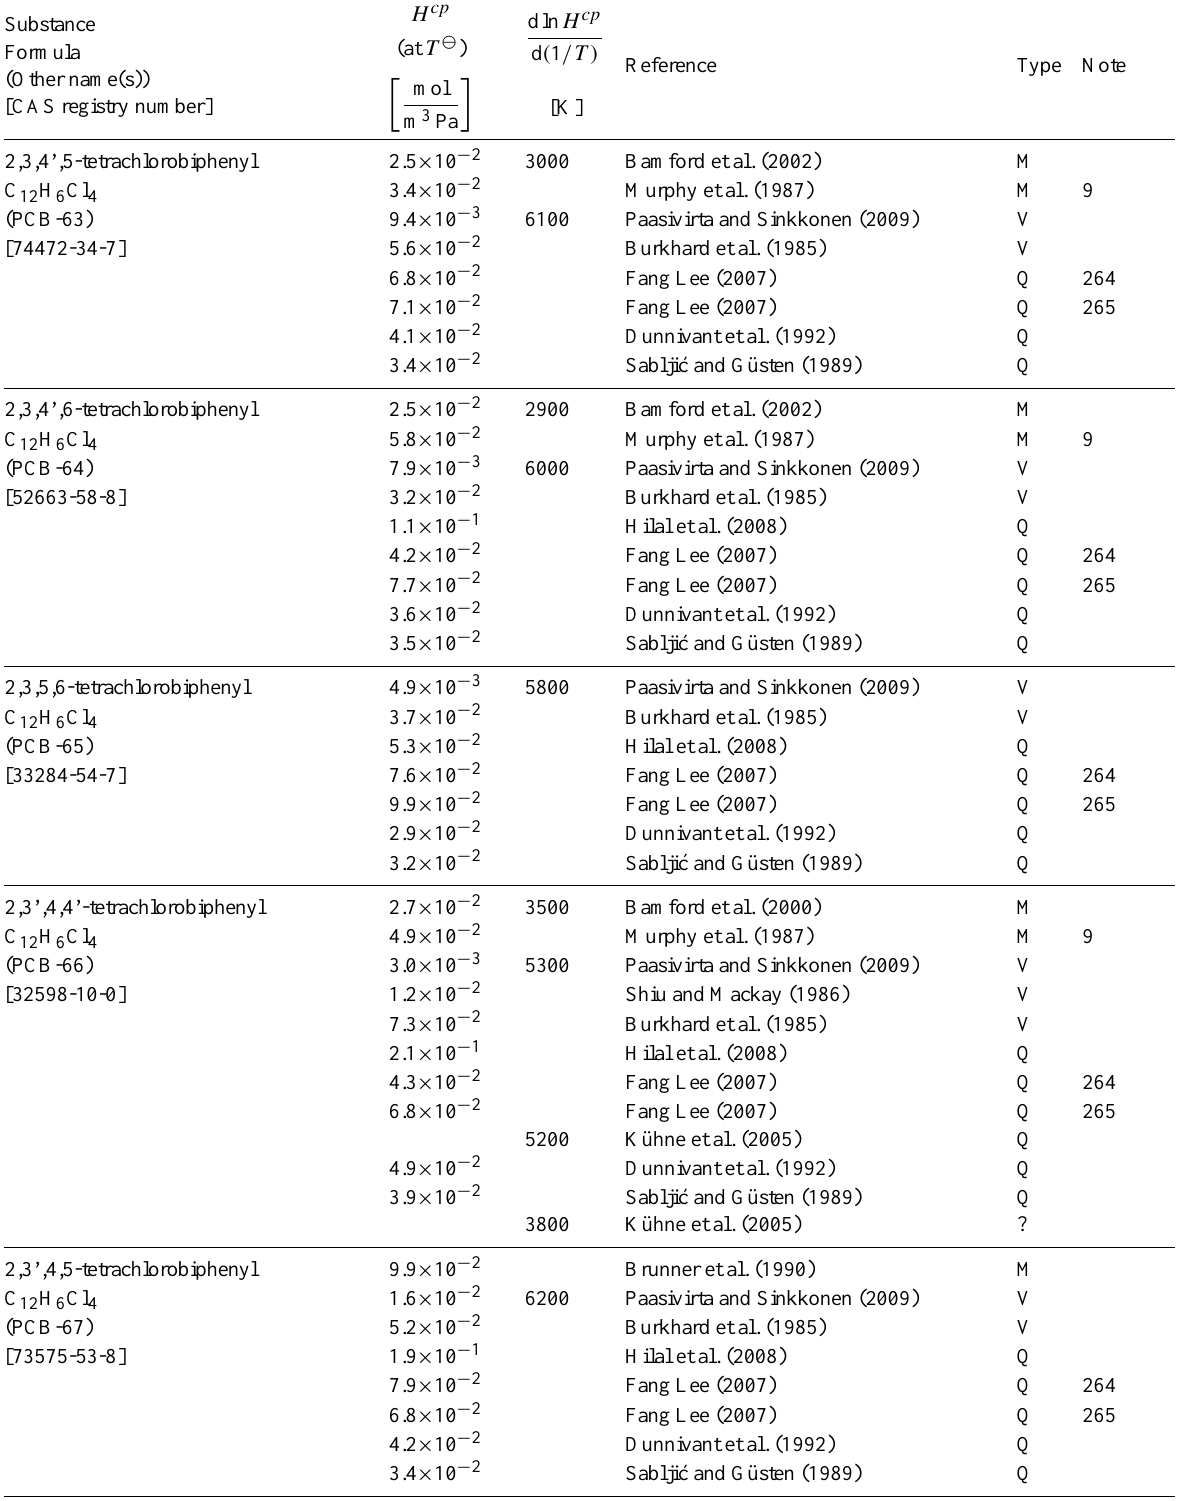
Table 6: Henry’s law constants for water as solvent